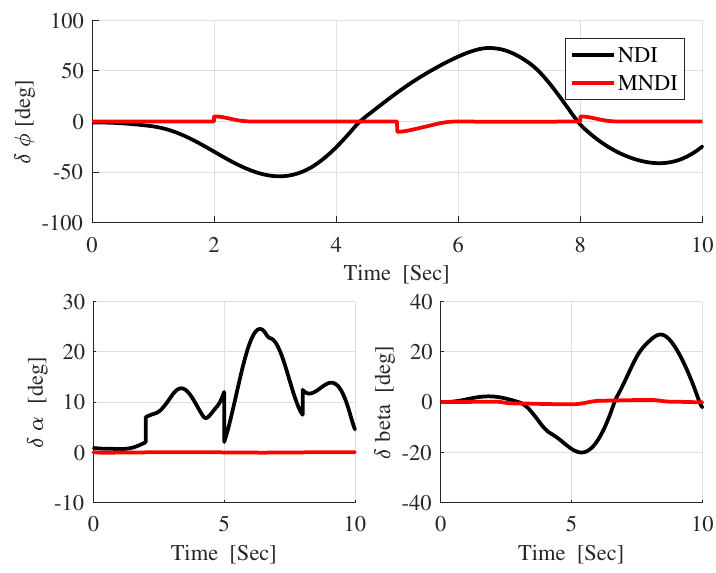
Figure 16. Inner loop rate response for outer roll angle excitation with wind and uncertainties.